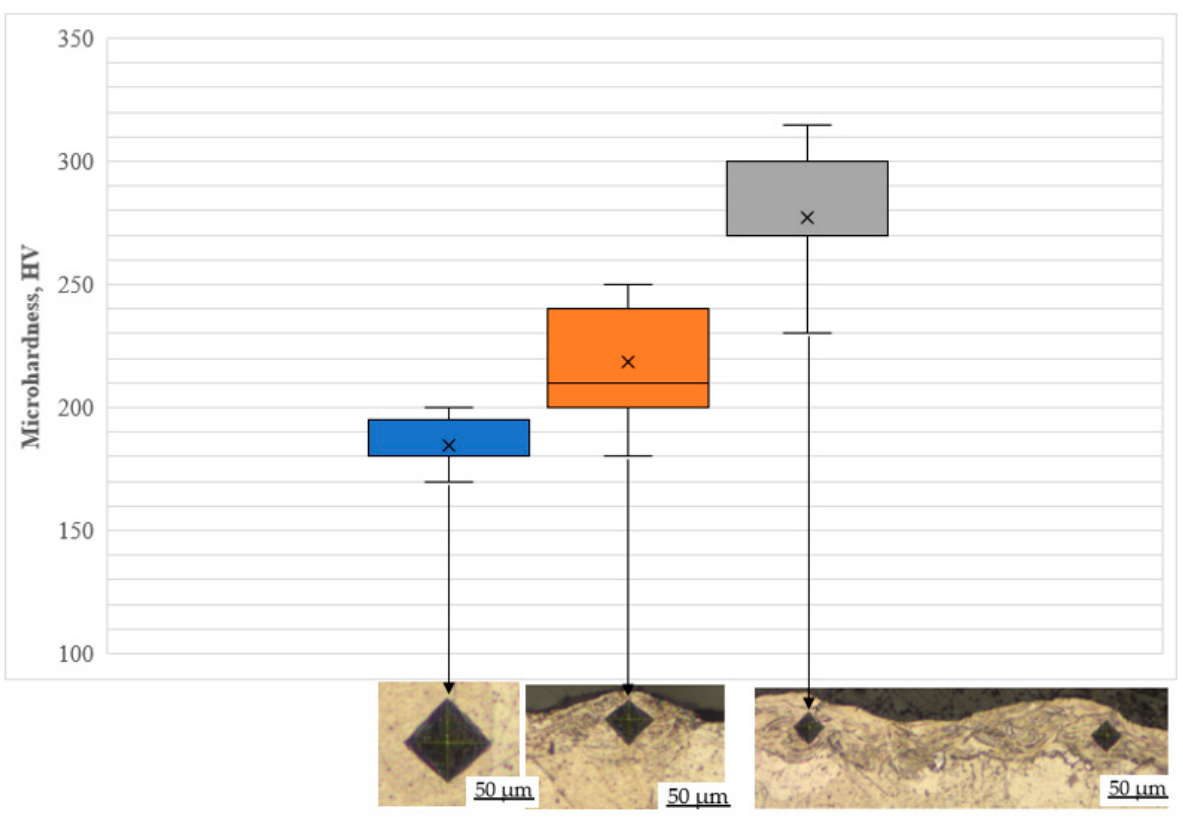
Figure 12. Microhardness values of the Ti5Mo-sintered tracks and layers.